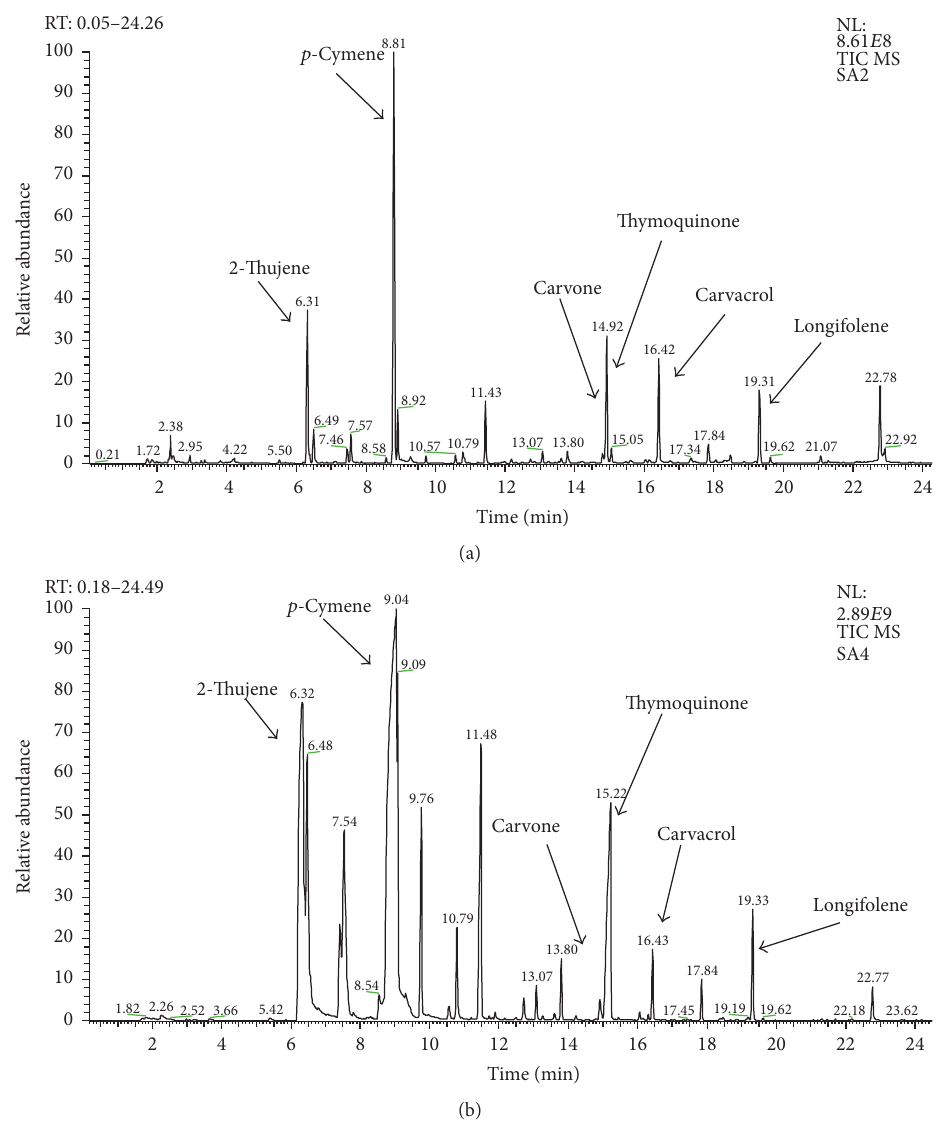
Figure 1: Total ion chromatogram (TIC) profile of whole N. sativa (a) and ground N. sativa